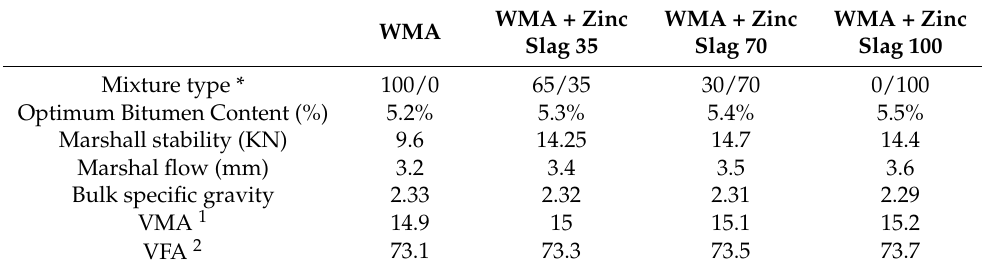
Table 2. Marshall mix design for the WMA mixtures used in this